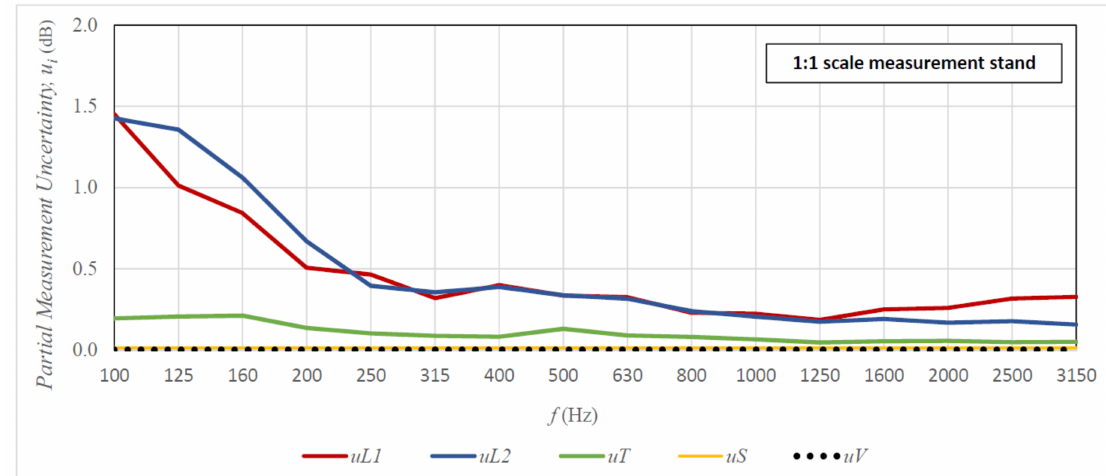
Figure 9. Share of measurement uncertainty of variables L 1 L 2 , T , S , and V in the total uncertainty of sound insulation mea- surement of the 1 × 2 m plexiglass specimen; measurements on the full-size stand for the 10-element measurement sample.